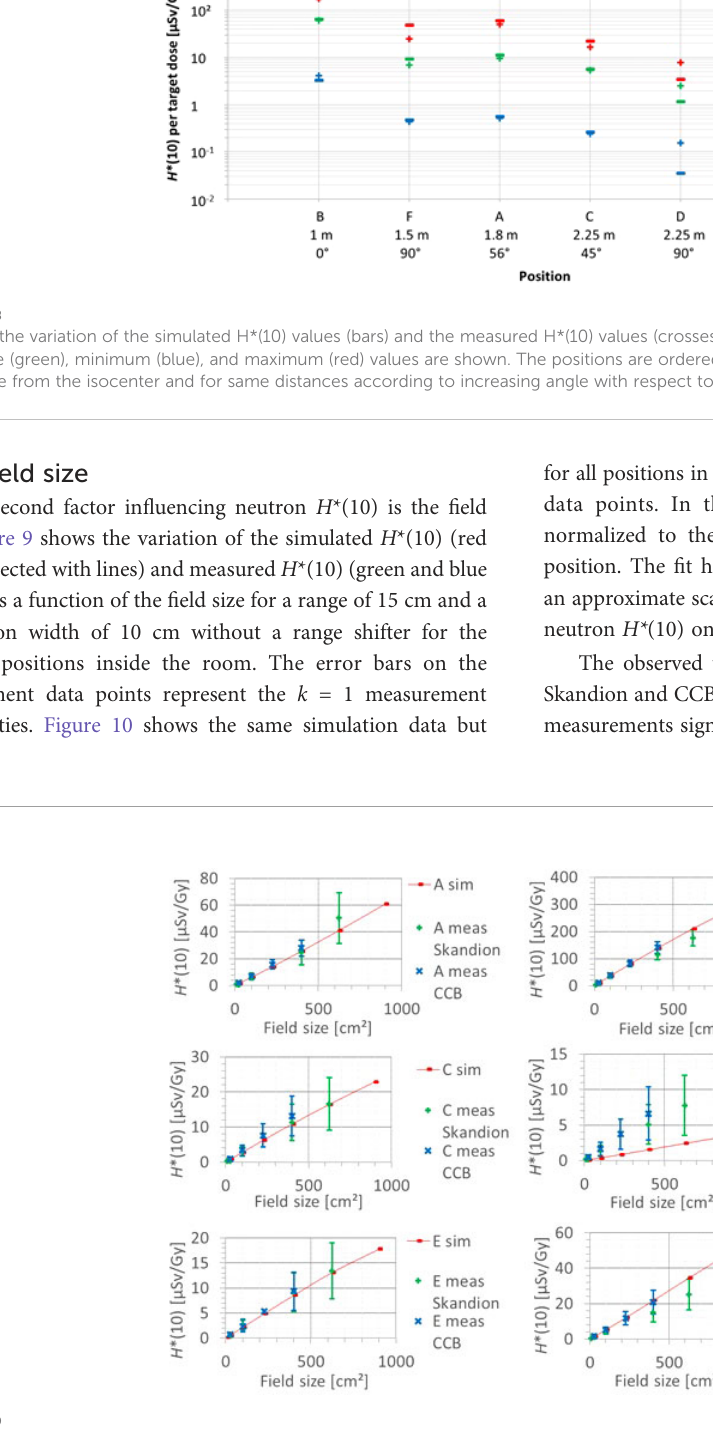
FIGURE 9 Plots of the variation of the simulated H*(10) (red bars) and measured H*(10) (green and blue crosses) as a function of the fi eld size for a range of 15 cm and modulation width of 10 cm without a range shifter for the different